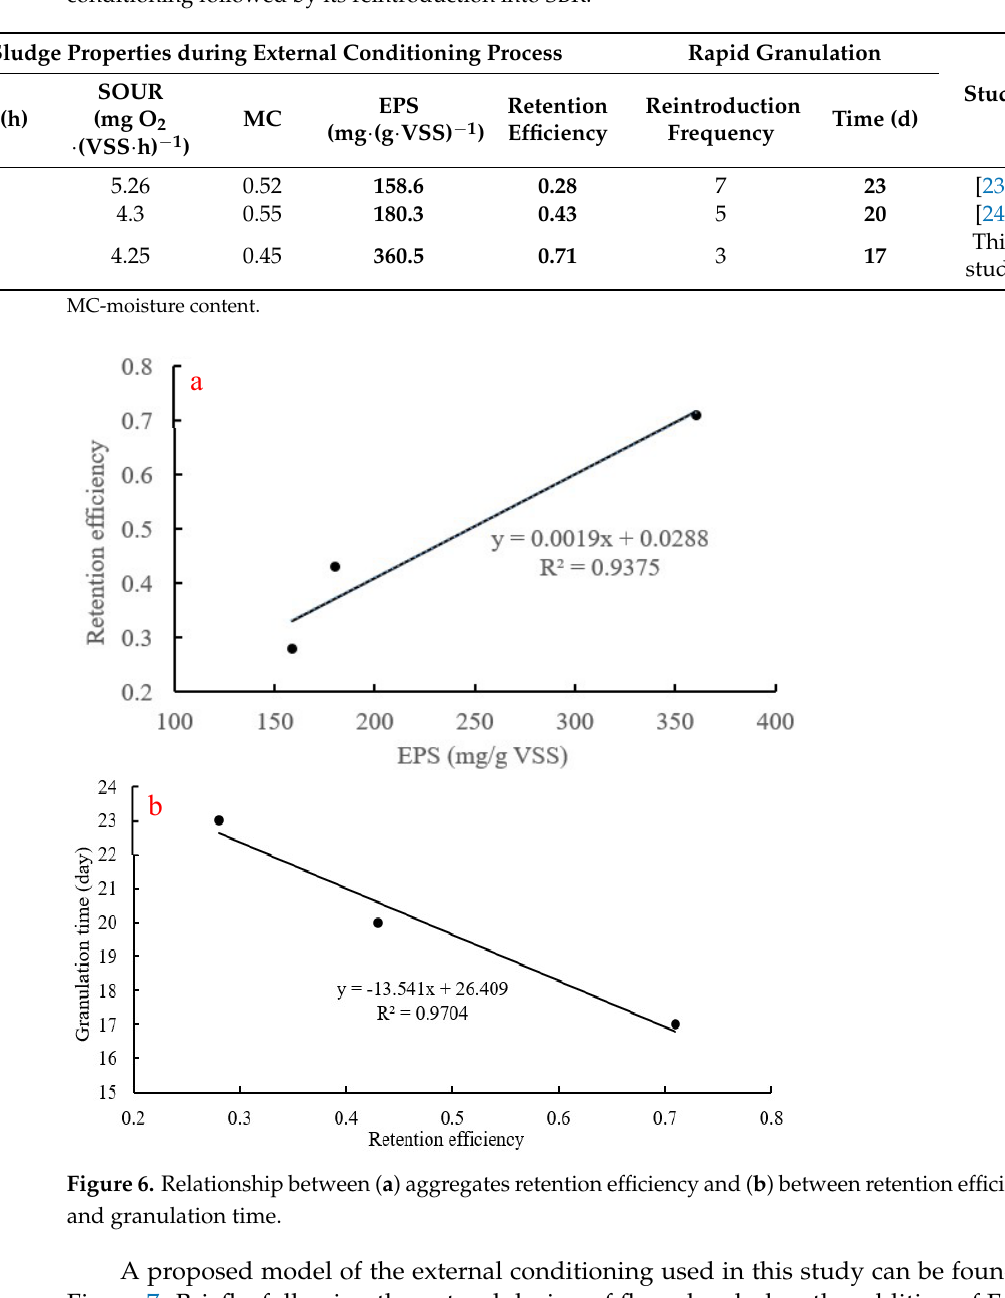
Table 3. Studies testing the efficiency of the rapid granulation process using effluent sludge external conditioning followed by its reintroduction into SBR.